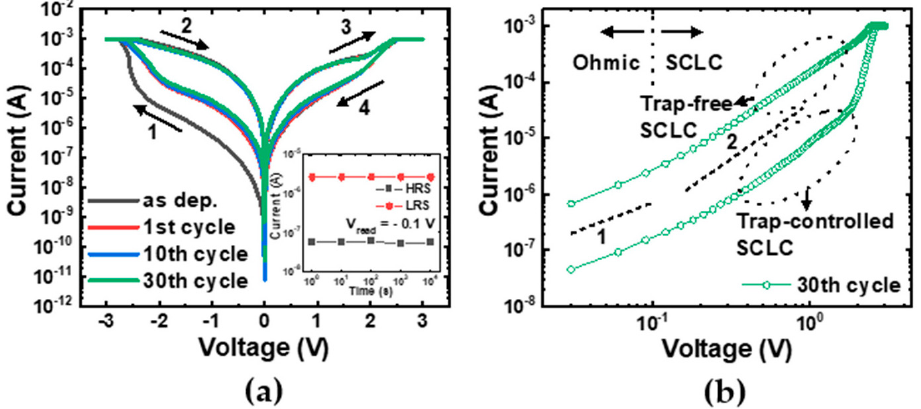
Figure 2. ( a ) The I–V characteristics of the fabricated Al/ α TiO x /Al interfacial RRAM devices for the initial and 30 cycles. The arrows indicate the direction of the voltage sweep. The inset shows the retention characteristics. ( b ) The double-logarithmic plot of the I–V curve at the 30th cycle.